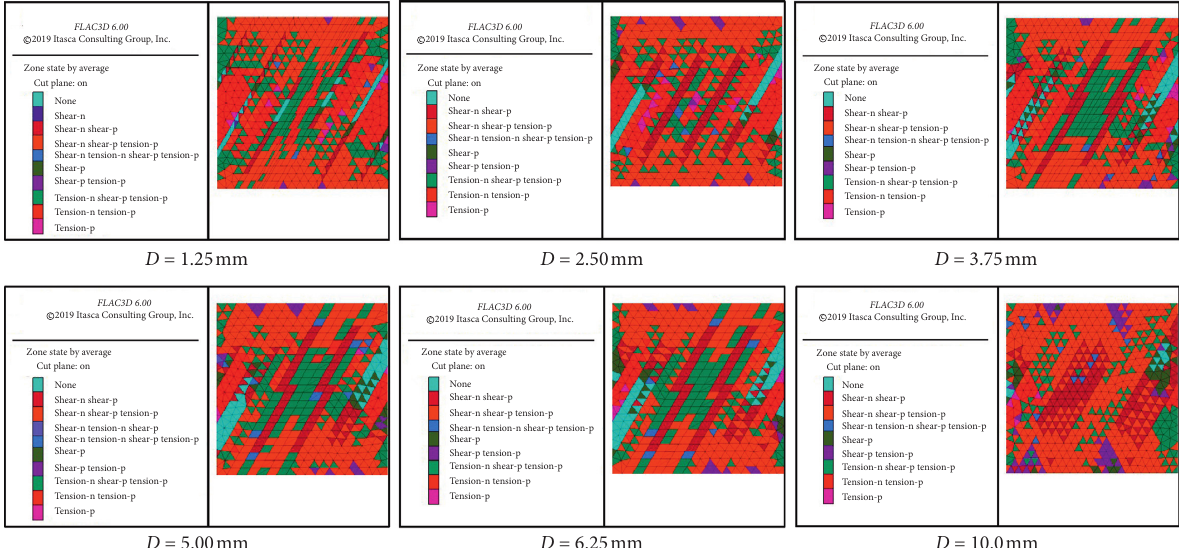
Figure 14: The view cutting contour of plastically deforming area in CJB with different joint thickness calculated by FLAC 3D